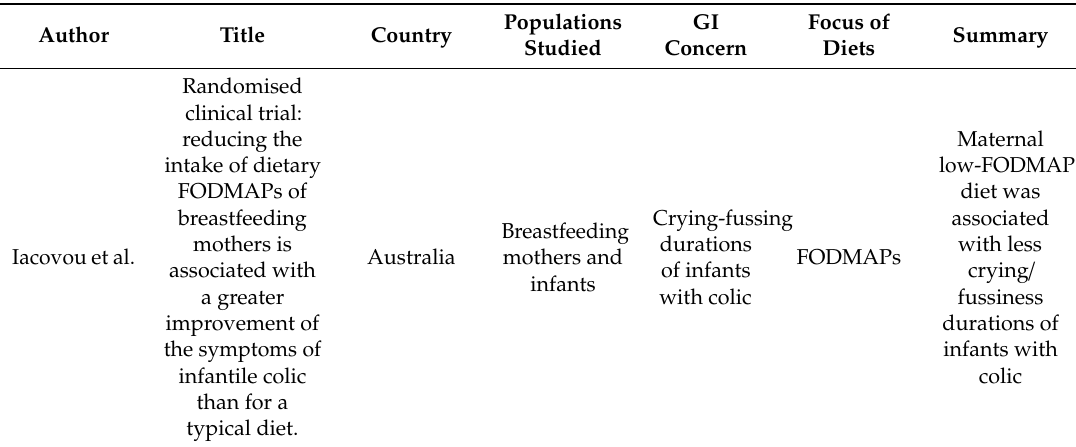
Table 1. Summary of included